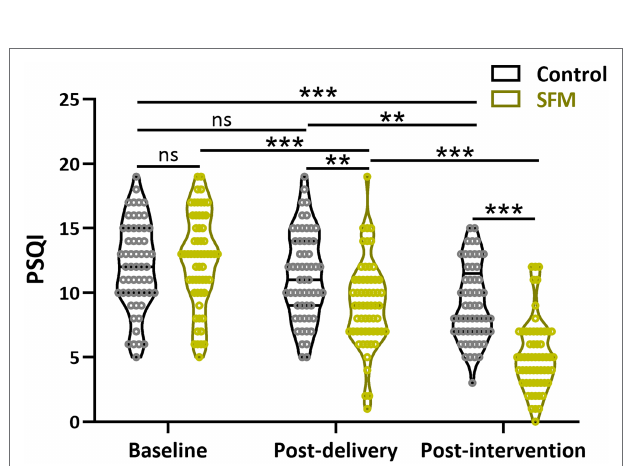
FIGURE 3 | Assessment of Pittsburgh Sleep Quality Index (PSQI) between the two groups at different time points. Values were presented with violin plot showing all the data. ** p < 0.01, *** p < 0.001, and ns, no significance. Two- way ANOVA test followed by Turkey multiple comparisons